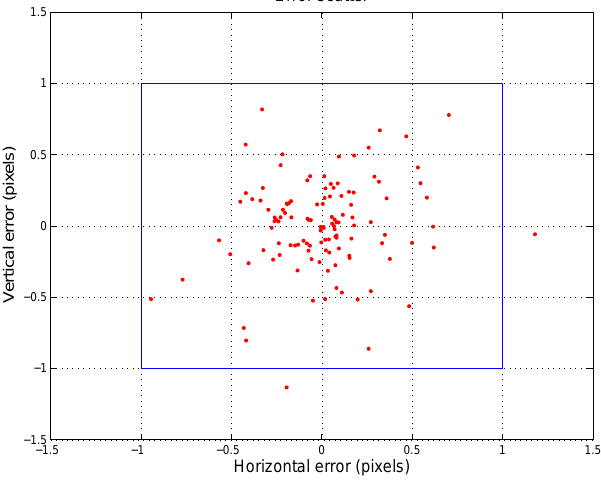
Fig. A5. Same as Fig. A3, but for the HAARPOON Apogee imager located at the HIPAS